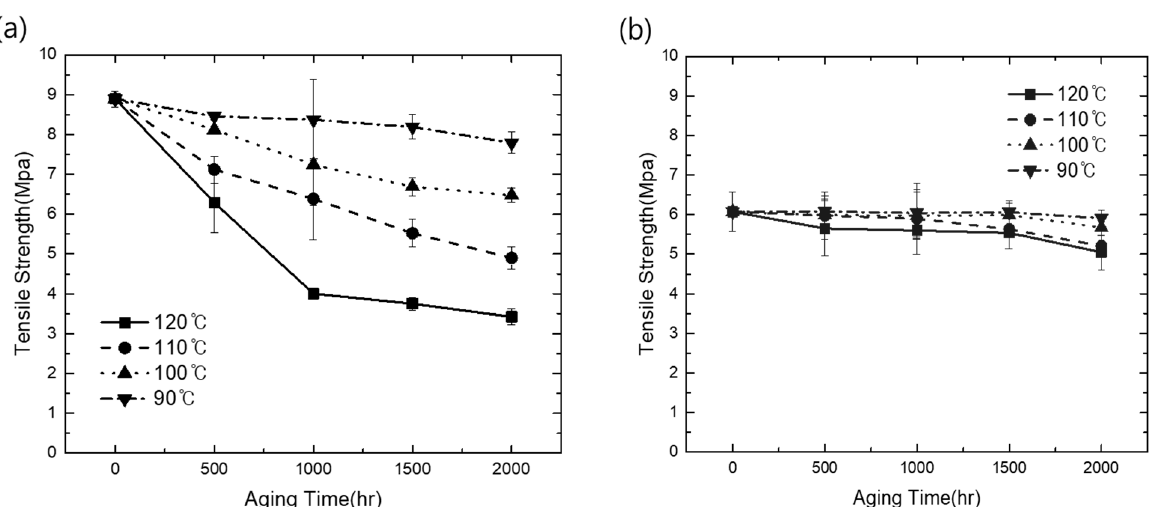
Figure 1. Comparison of tensile thermal oxidation aging results: ( a ) tensile strength changes of EPDM; ( b ) tensile strength changes of TPV.